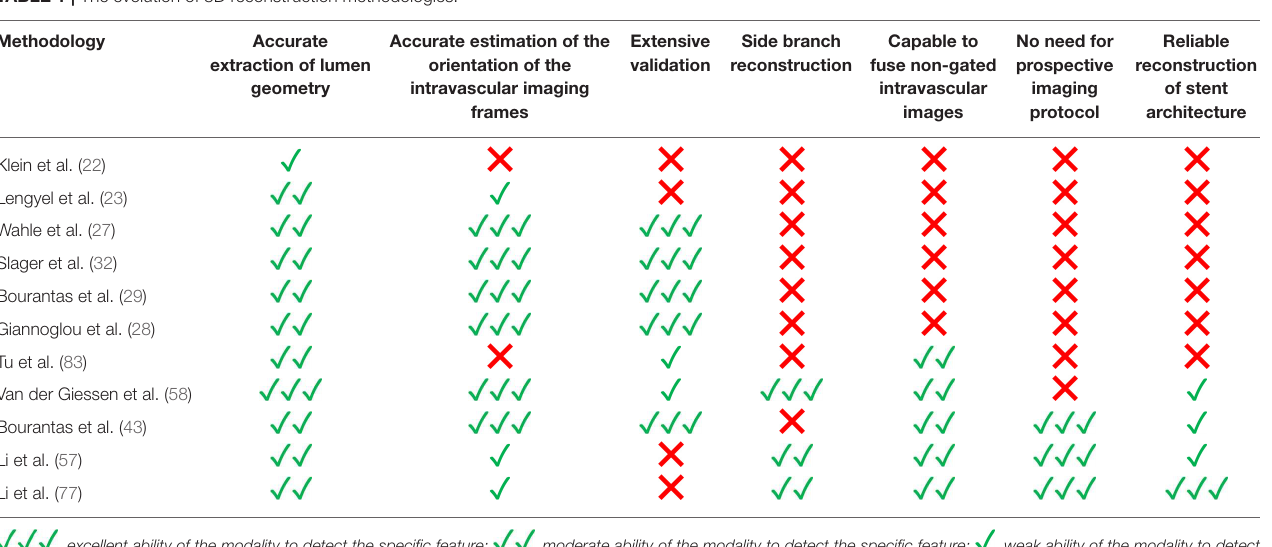
TABLE 1 | The evolution of 3D reconstruction